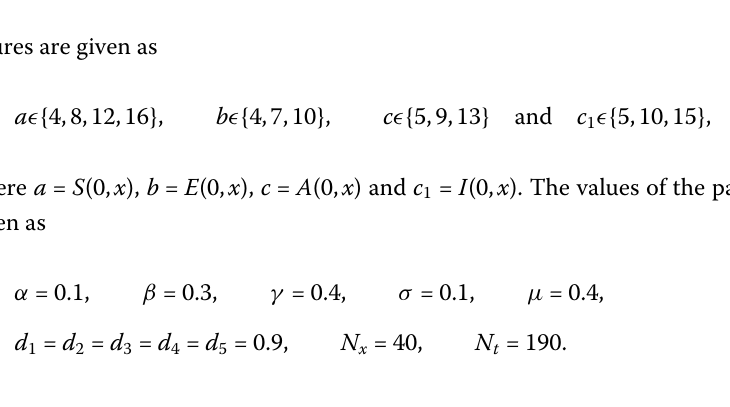
Figure 8 Two dimensional phase portrait of infected and asymptomatic individuals